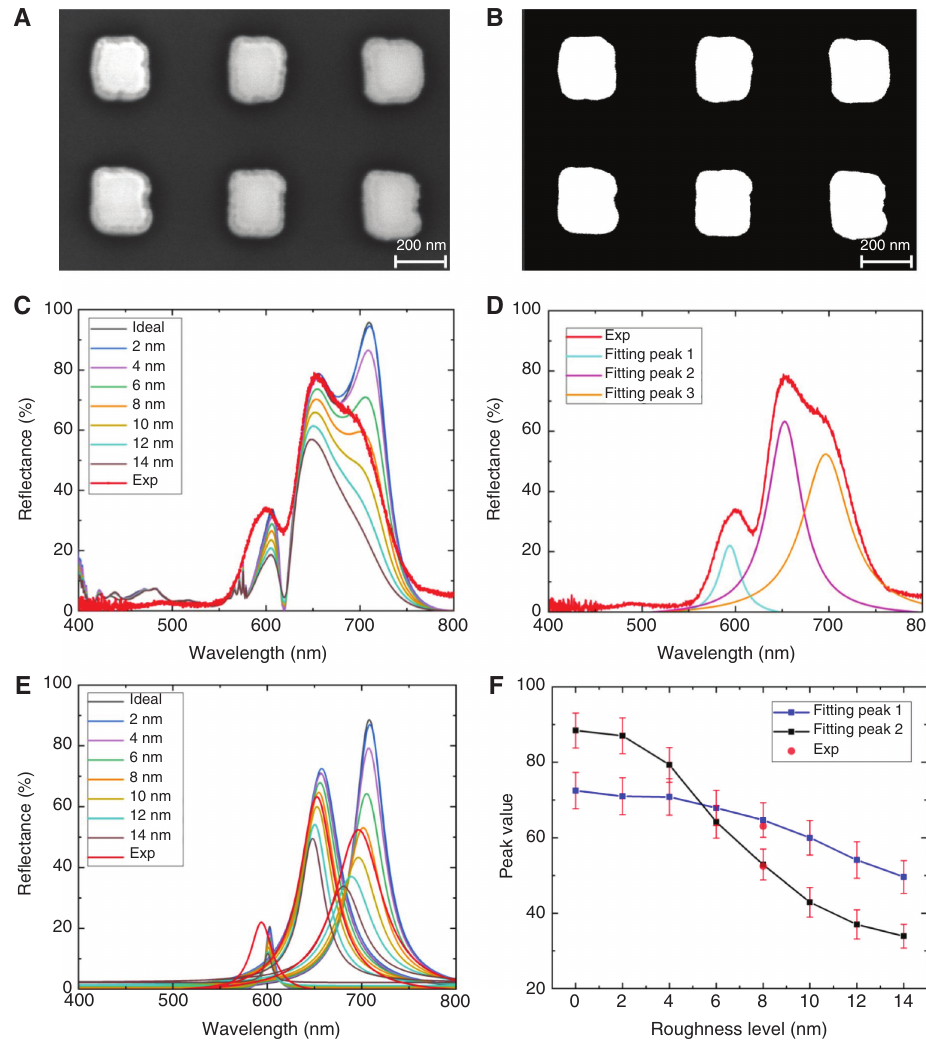
Figure 4: Calculated results of effects of different level roughness. (A) Top-view SEM image of all-dielectric metasurface. The roughness of nanopillars can be observed clearly. (B) Edge detection result of SEM image in (A). The average roughness scale is 8 nm (3 σ ). (C) Calculated reflection spectra with different levels of roughness and the measured reflection spectrum of the all-dielectric metasurface at normal incidence. (D) Resonant-mode extraction from fitting the measured reflection spectrum of fabricated all-dielectric metasurface. The three fitted peaks are at 594, 653, and 697 nm, respectively. Note that the second (653 nm) and third (697 nm) peaks correspond to the main optical resonances. The first peak (594 nm) represents the side lobe in the shorter wavelength region. (E) Resonant-mode extraction for the calculated reflection spectra in (C). Higher level of roughness has much more effect on the second peak, which is consistent with previous conclusion. (F) The change of the two fitting peaks in the reflection spectra with respect to the roughness level. The two red points are the experimental results, which demonstrate the effectiveness of the